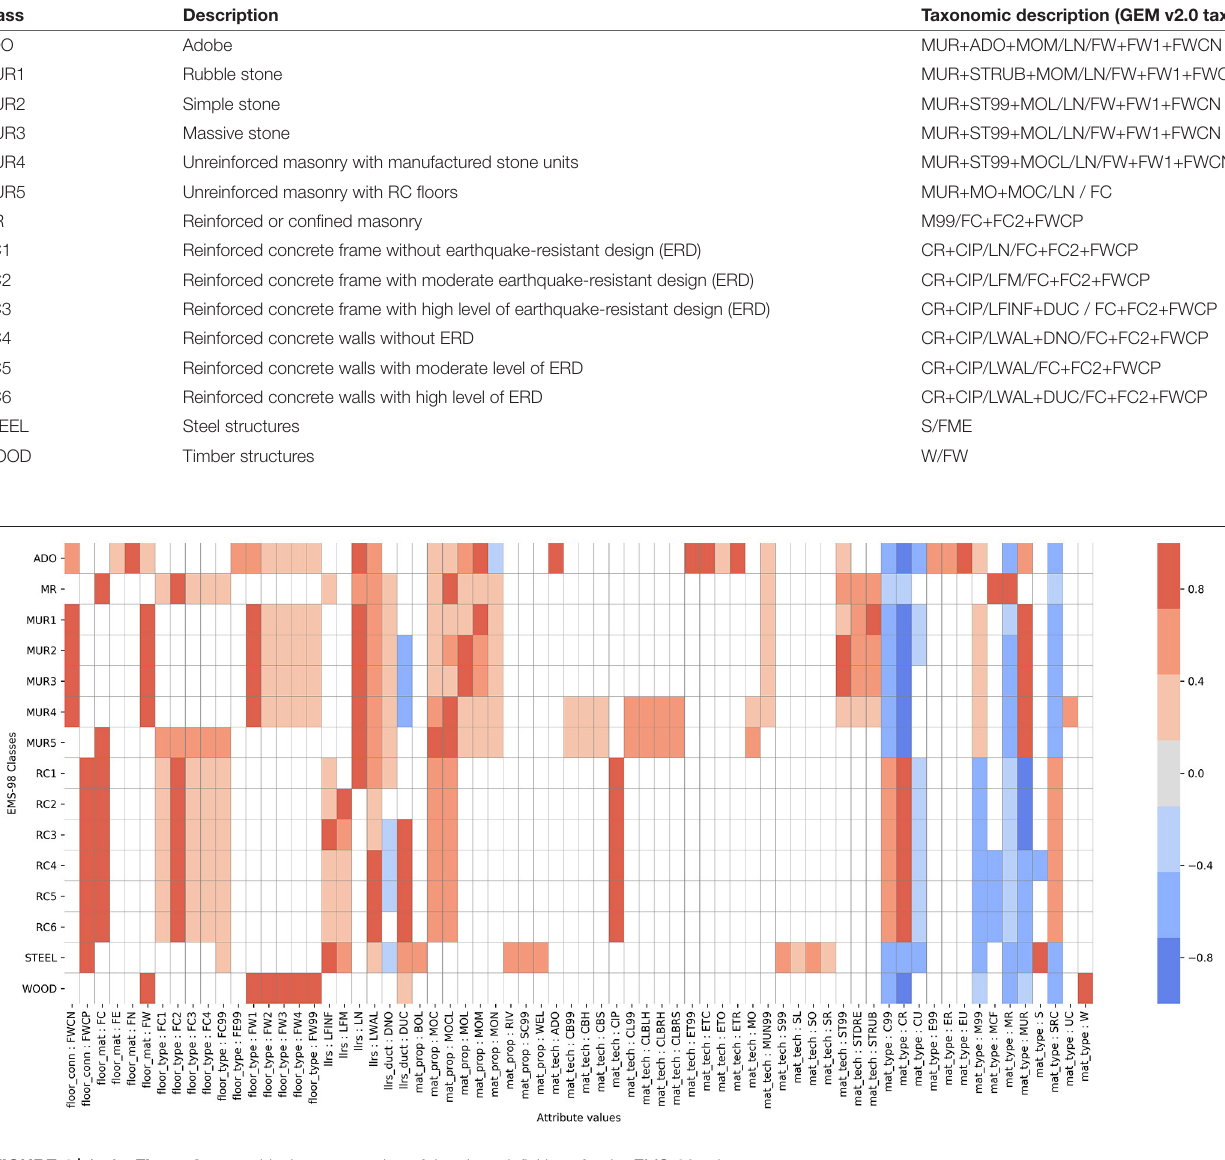
FIGURE 4 | As for Figure 3 , a graphical representation of the class definitions for the EMS-98